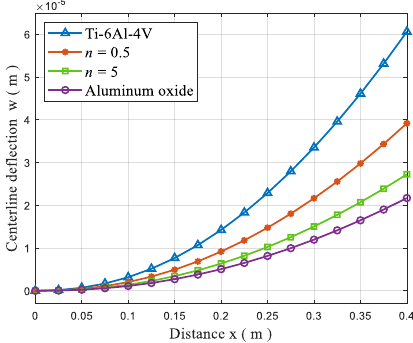
Figure 7. Deflection of a cantilevered PFGP under an input voltage of 10 V with different n .